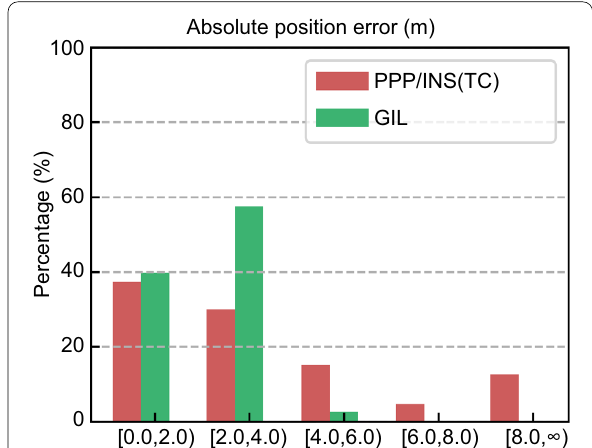
Fig. 14 Distribution of absolute position offsets of the multi-GNSS PPP/INS and GIL methods in GNSS difficult